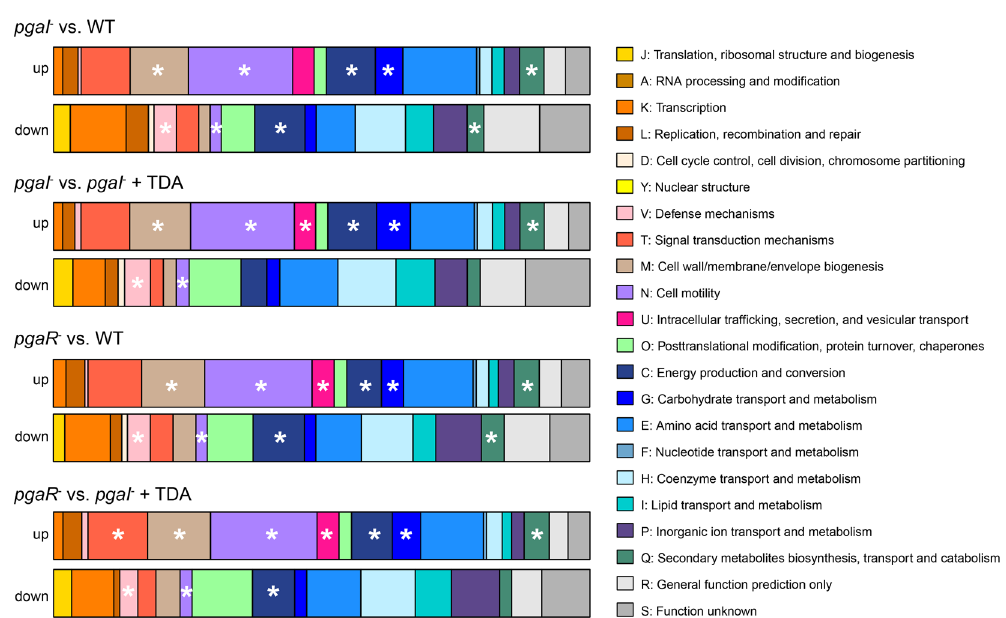
Figure 2. Functional groups of differentially expressed genes of WT and mutants of P. inhibens according to the database of clusters of orthologous groups of proteins (COGs). Up- and down-regulated COGs of each mutant strain with respect to gene expression of the P. inhibens WT or the pgaI mutant + TDA. Asterisks indicate significantly enriched COG categories. Data for each of the AHL mutants compared to the WT or pgaI − + TDA show that the same functional COG categories are up- or down-regulated in a similar number of genes.